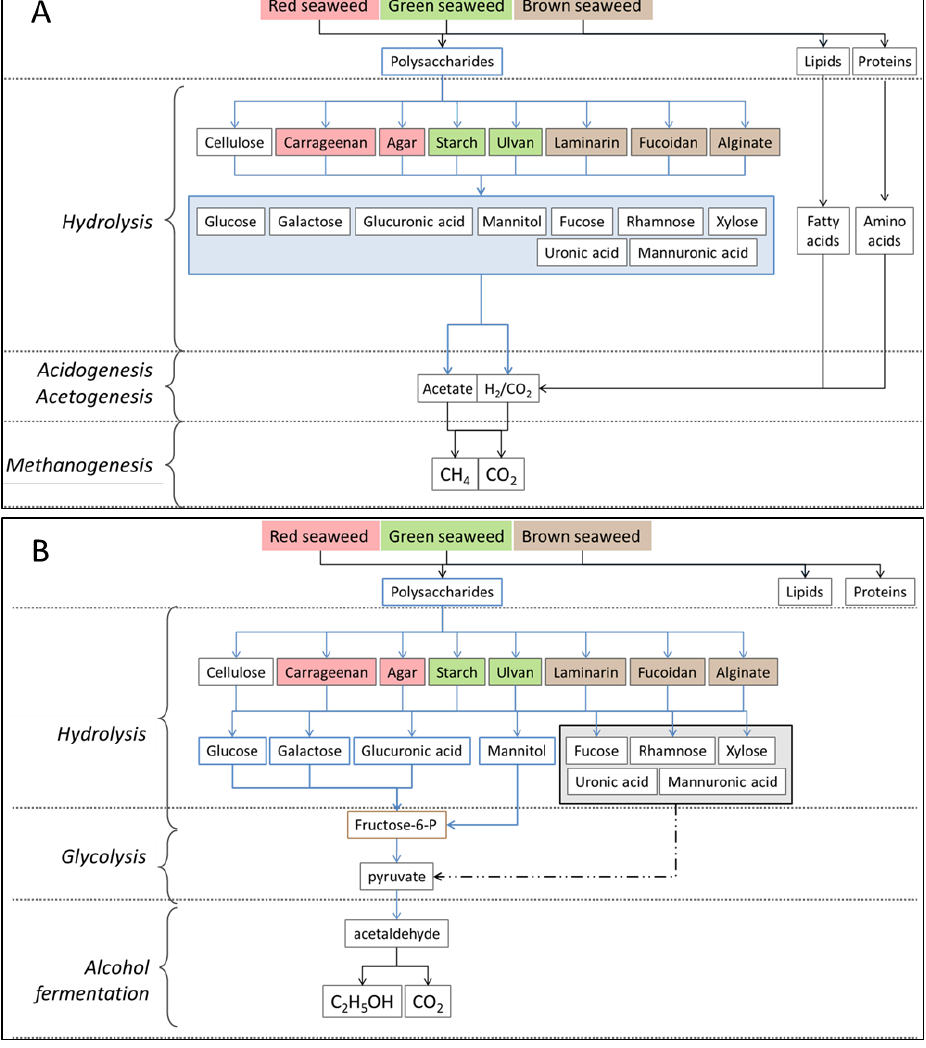
Figure 1. Major steps for biogas production ( A ), or ethanol production ( B ) from harvested seaweed. Polymeric cellulose, lipids, and proteins are found in all red, green and brown seaweeds. Additionally, the polymeric polysaccharides carrageenan and agar, colour-coded red, are typical of red seaweeds; starch and ulvan, colour-coded green, typical of green seaweeds, and laminarin, fucoidan, and alginate, colour-coded brown, typical of brown seaweeds. See also Wei, Quarterman and Jin (2013) [16].